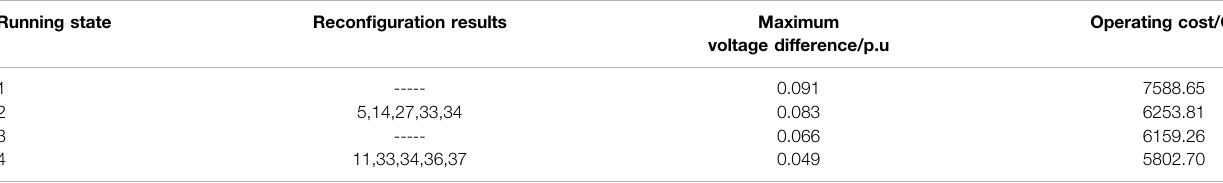
TABLE 2 | Comparison of results in four running states. Running